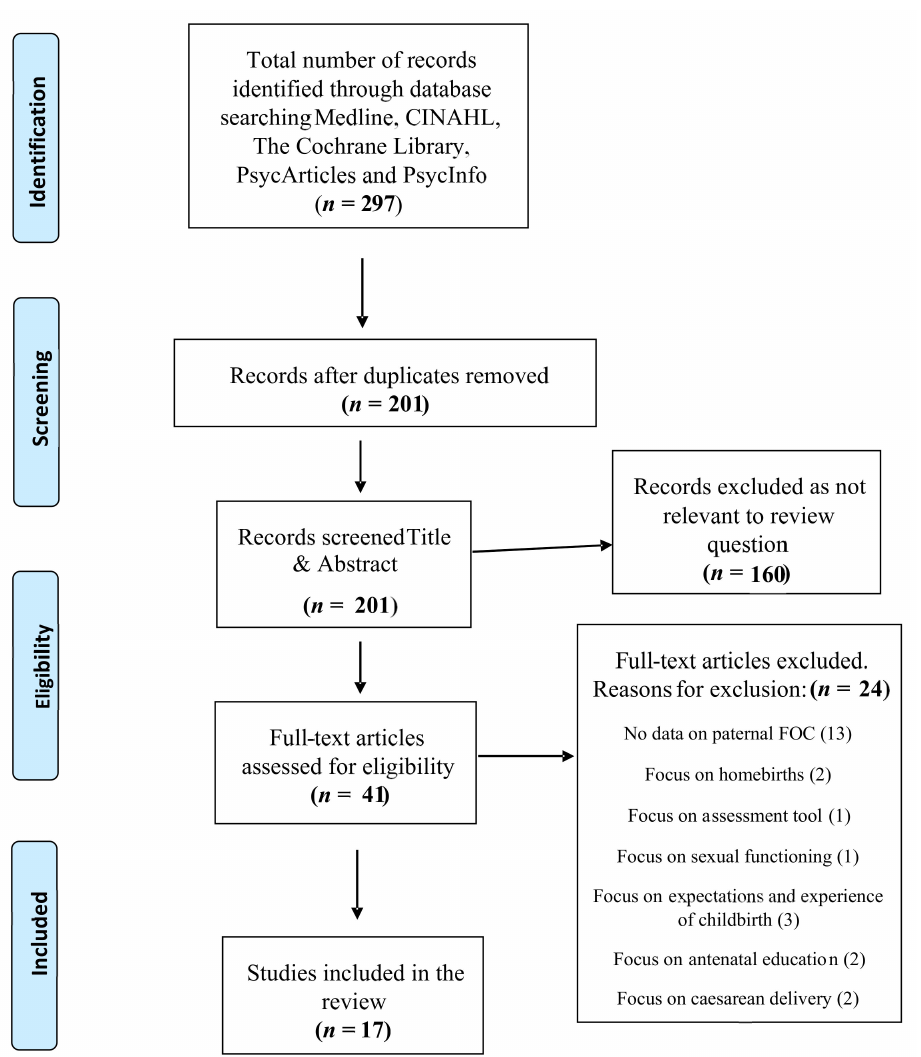
Figure 1. Prisma flow diagram. FOB = Fear of